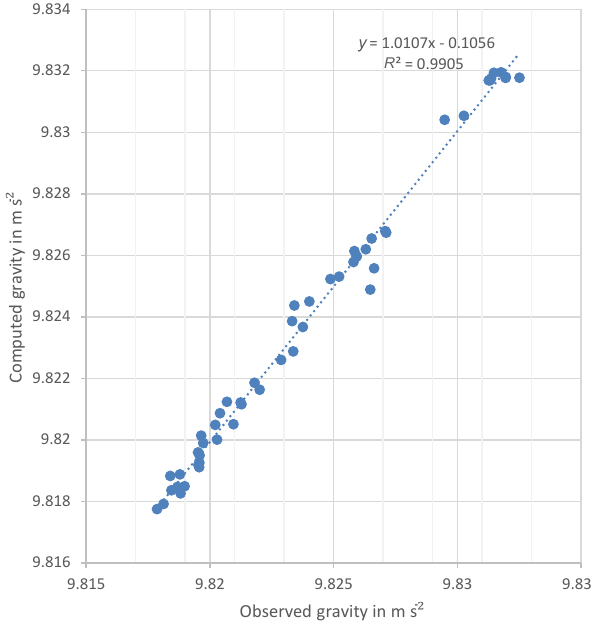
Figure 4. Computed gravity values compared to observed gravity values with Sterneck pendulums for latitudes between 58 ◦ N and 86 ◦